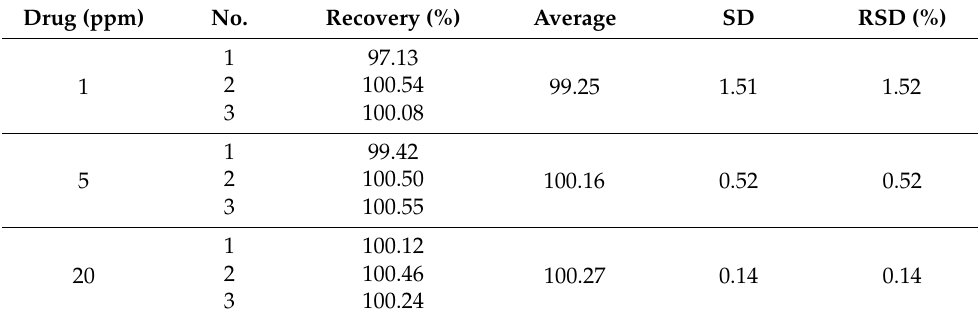
Table 3. Accuracy data obtained from the developed analytical method for P18. Drug (ppm)